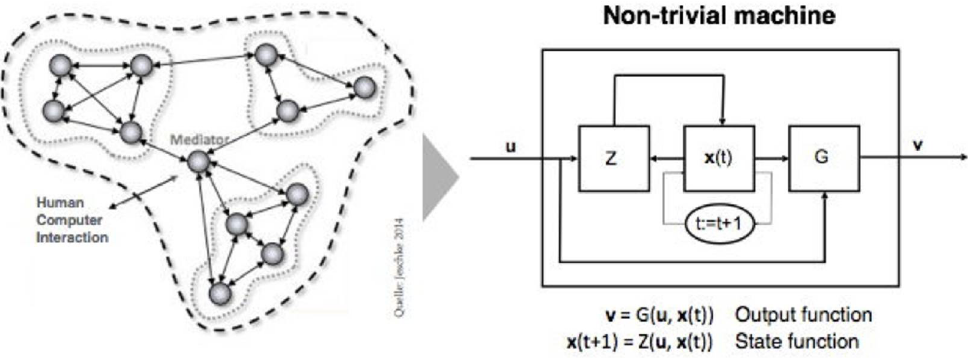
Figure 1. MAS as »non-trivial machine« [2] (adapted from [3]).